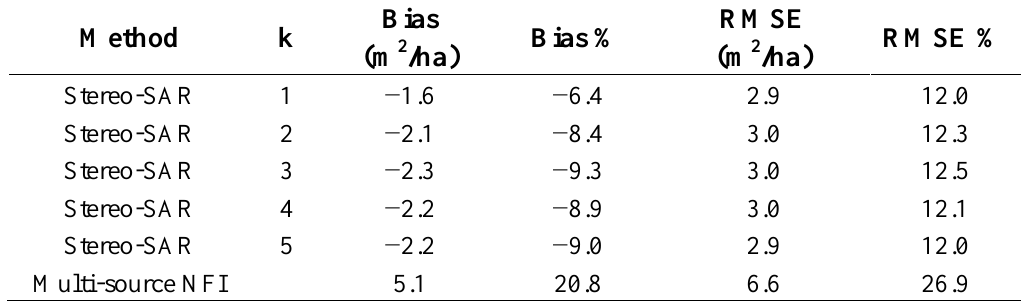
Table 4. Stand-level estimation accuracy of forest basal area by stereo-SAR and multi-source